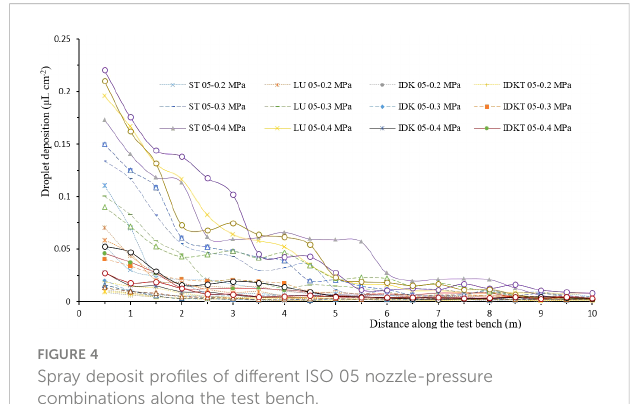
FIGURE 4 Spray deposit pro fi les of different ISO 05 nozzle-pressure combinations along the test bench.